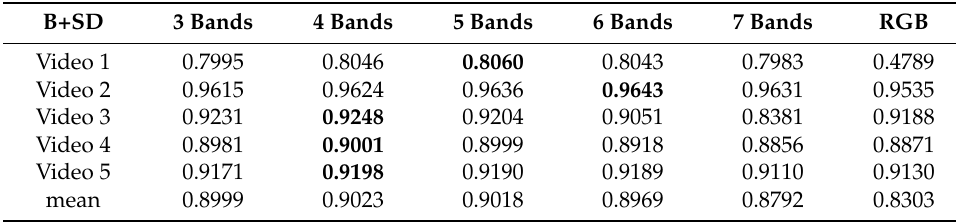
Table 2. Best F-measures with B+SD on five videos.